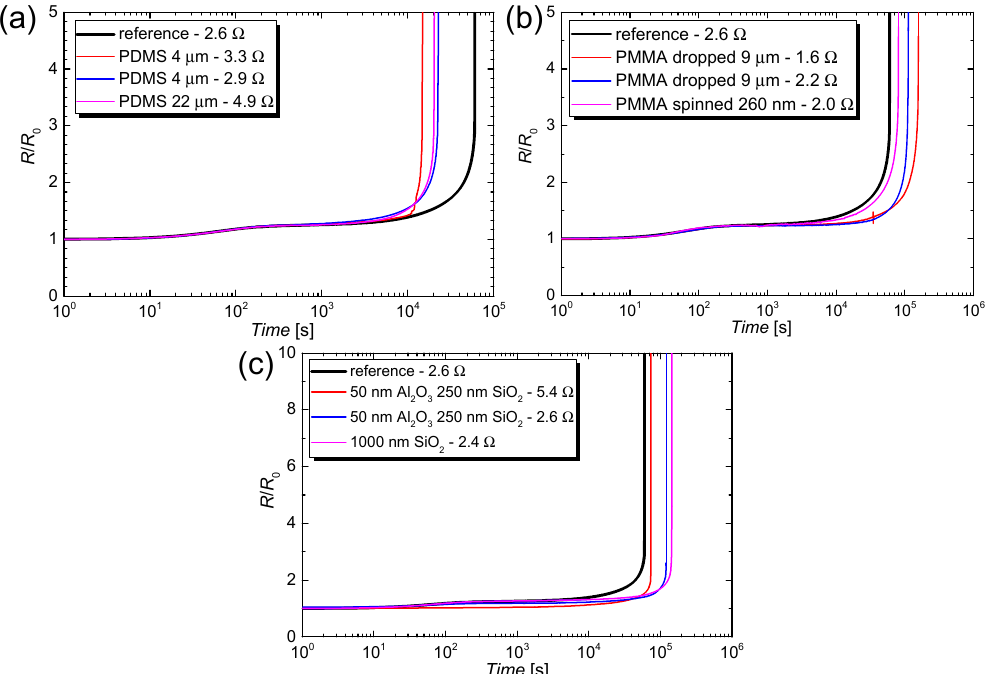
Figure 14. Normalized increase in resistance R / R 0 as a function of the time for CuNW films coated with ( a ) PDMS, ( b ) PMMA and ( c ) SiO 2 and Al 2 O 3 . The CuNW films were heated over an effective area of 3.5 × 5 cm 2 by applying an electrical input power of 6